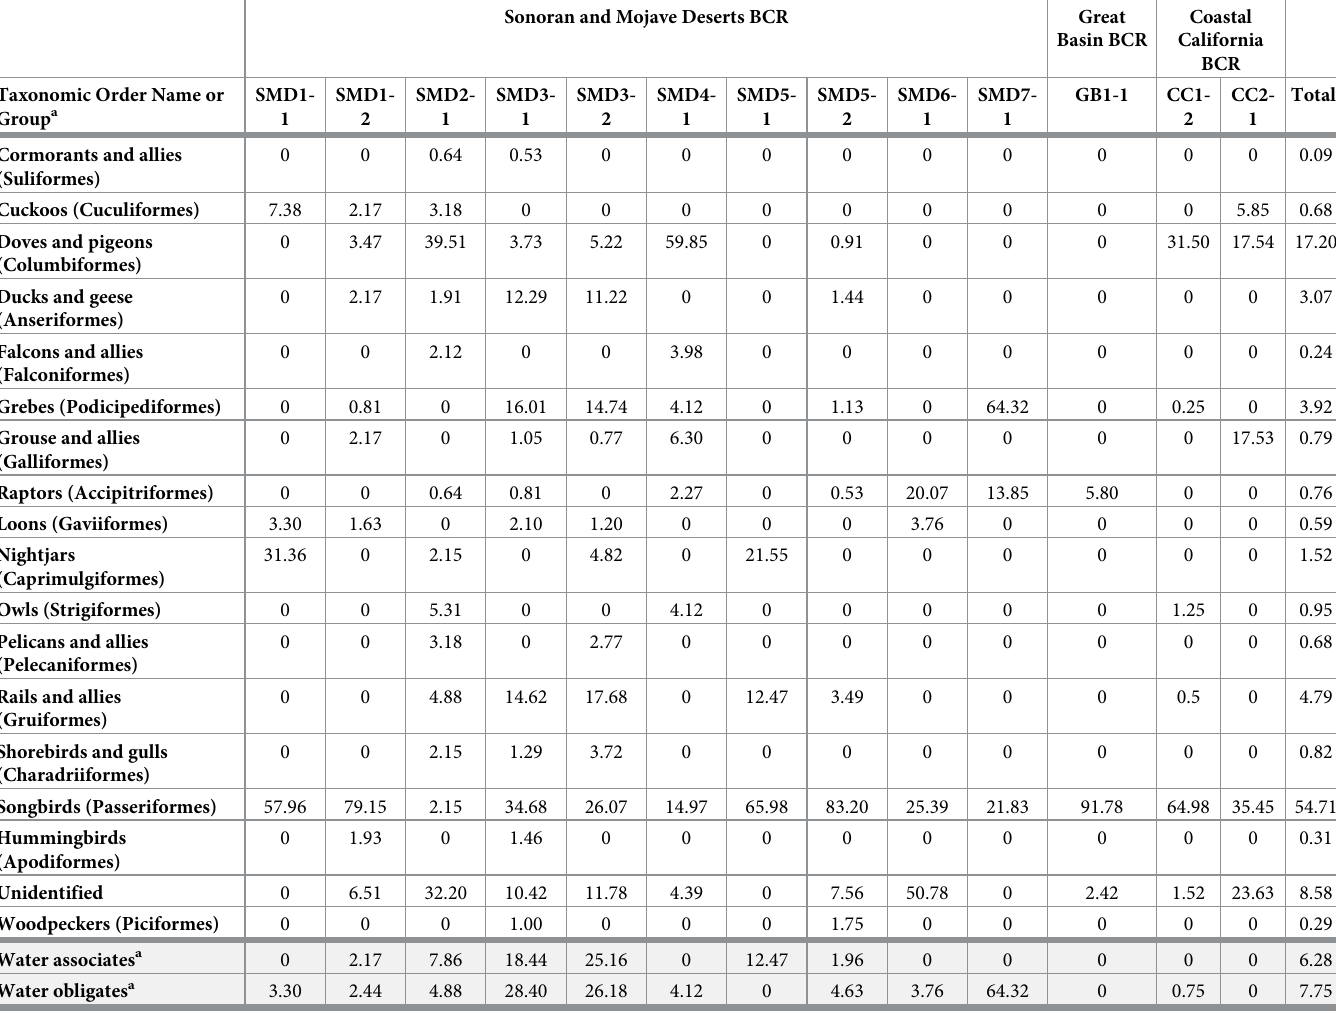
Table 1. Adjusted composition by taxonomic order (or group) by Bird Conservation Region (BCR) provided in fatality monitoring reports from January 1, 2013, to September 1, 2018. Data are presented by site-year so that SMD1-1 is the first year report for site SMD1 and SMD1-2 is the second year report for site SMD1. Sonoran and Mojave Deserts